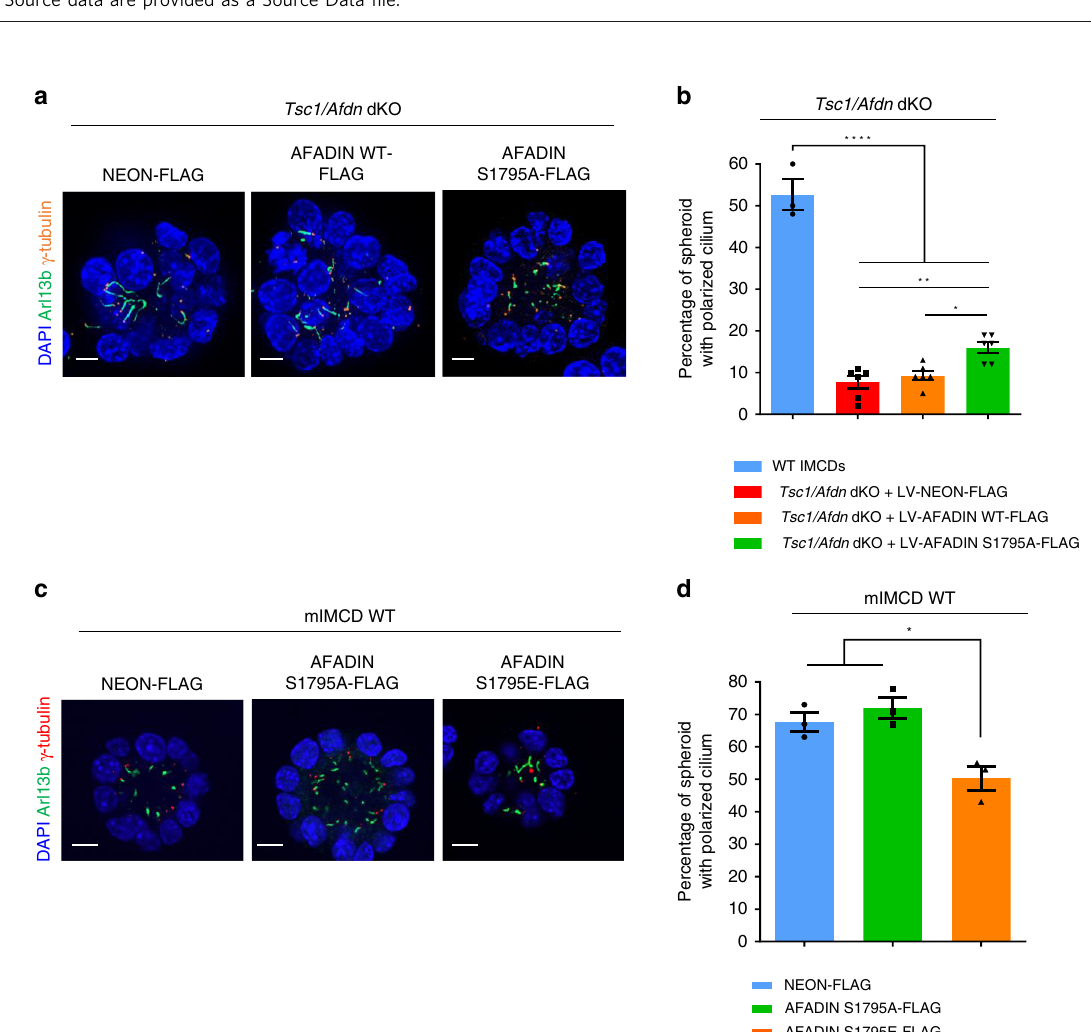
Fig. 7 Afadin is phosphorylated by S6K1 in Tsc1 -mutant conditions. a Cells were serum starved overnight and subsequently amino acid starved with EBSS (Earle ’ s Balanced Salt Solution) for 1.5 h with or without the indicated treatments. They were then collected and cell lysates were probed with the indicated antibodies. Asterisk represents non-speci fi c cross-reactive bands. b Densitometry analysis and relative quanti fi cation of the phosphorylated forms of the indicated proteins. Actin was used as a loading control. Mean ± SEM. n = 4 independent experiments were analyzed. c Western blots of mouse whole- kidney extracts at pre-cystic age (post-natal day 20), randomly fed, and probed with the indicated antibodies. d Densitometry analysis and relative quanti fi cation of the phosphorylated form of Afadin. Actin was used as a loading control. Mean± SEM. n = 3 Tsc1 f/f, n = 3 Tsc1 f/f; S6k1 − / − , n = 4 Ksp- Cre; Tsc1 f/f, and n = 4 Ksp-Cre; Tsc1 f/f; S6k1 − / − mice were analyzed. e Western blot of protein lysates extracted from patient samples. Renal tumors (t) or normal tissue adjacent to renal tumor (n) were collected from TSC patients and non-TSC patients. Protein lysates then probed with the indicated antibodies. f Densitometry analysis and fold change of TSC patients over non-TSC patients of the indicated proteins relative to the indicated loading control. Mean± SEM. n = 5 TSC patients, n = 7 non-TSC patients were analyzed. g Analog-sensitive S6K1 was co-transfected in Tsc1/S6k1 dKO mIMCD3 cells with FLAG-Afadin-WT. An in vivo kinase assay was performed in the presence of 6 ‐ Bn ‐ ATP ‐ γ ‐ S both in presence and in absence of 20 nM rapamycin. After immunoprecipitation using an anti-FLAG antibody, the thio-phosphorylation of Afadin was revealed by western blot using an anti ‐ thiophosphate ester antibody. Expression levels of Afadin, phospho-S1795-Afadin, FLAG and phospho-RPS6 were revealed by western blot on total extracts using the indicated antibody. Source data are provided as a Source Data fi le.